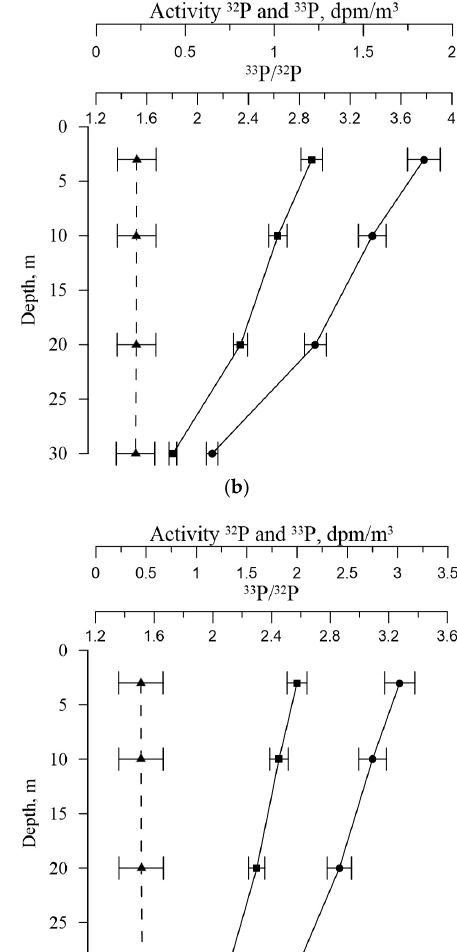
Figure 6. Values of 32 P and 33 P activity and 33 P/ 32 P ratio in the particulate matter for different hori- zons: ( a ) winter 2021; ( b ) spring 2022; ( c ) summer 2022, ( d ) autumn 2022 ( 32 P ( ■ ), 33 P ( ● ), 33 P/ 32 P ratio ( ▲ )).